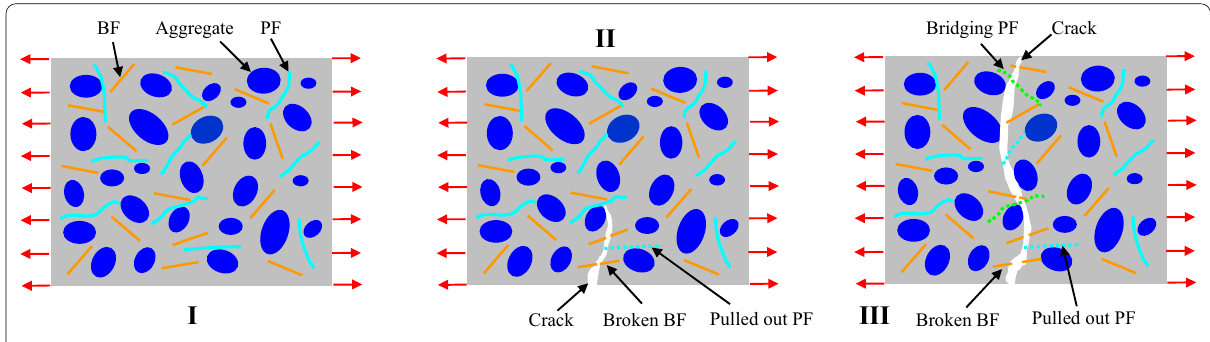
Fig. 11 Action mechanism of BF and